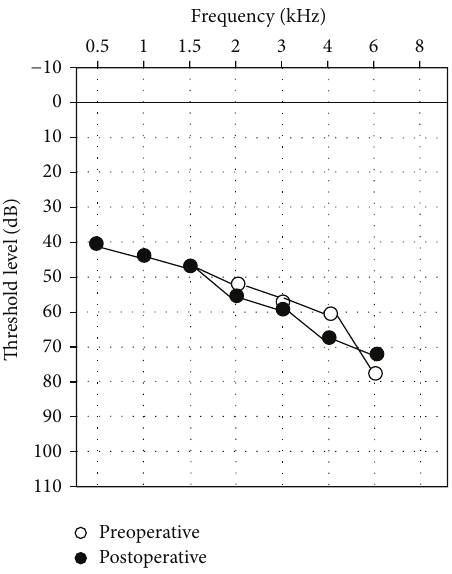
Figure 1: Comparison of the pre- and postoperative BC.